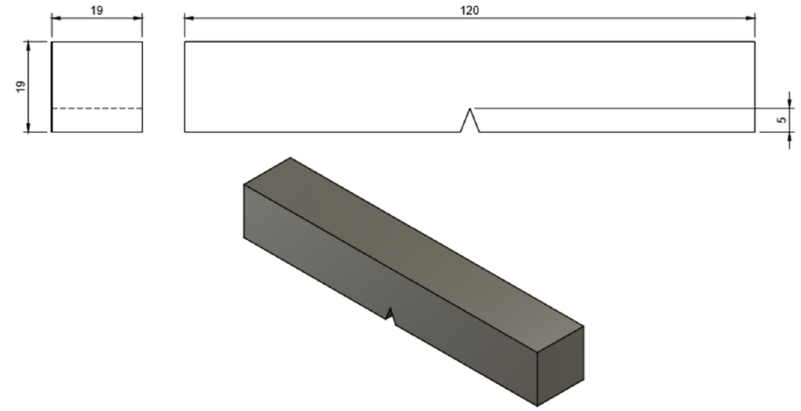
Figure 1. Dimensions of the crack tip opening displacement test (CTOD) specimen.